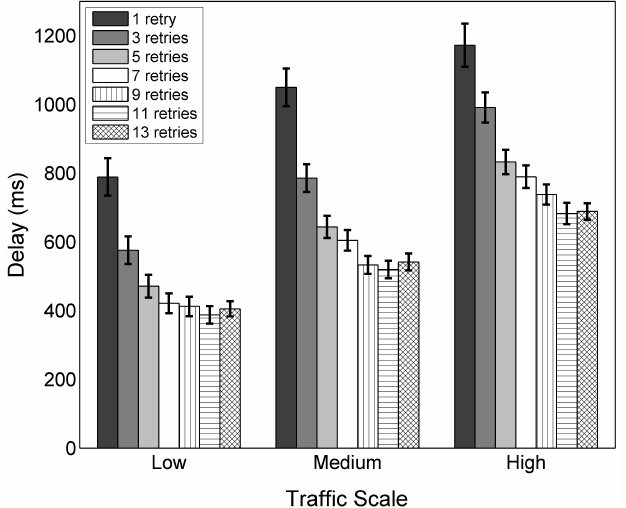
Figure 6. The average end-to-end delays observed with the corresponding 95% confidence intervals for different values of macMaxFrameRetries in different traffic